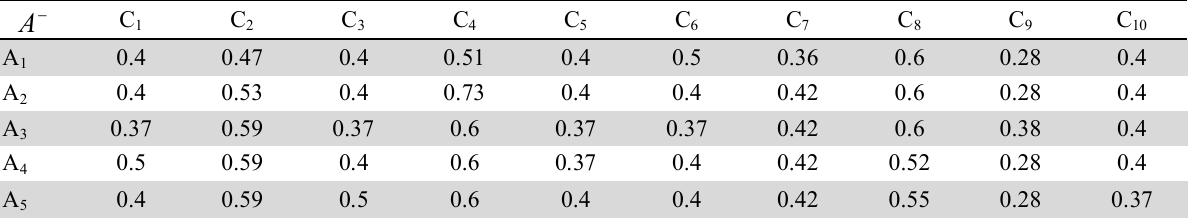
Fuzzy negative ideal solution